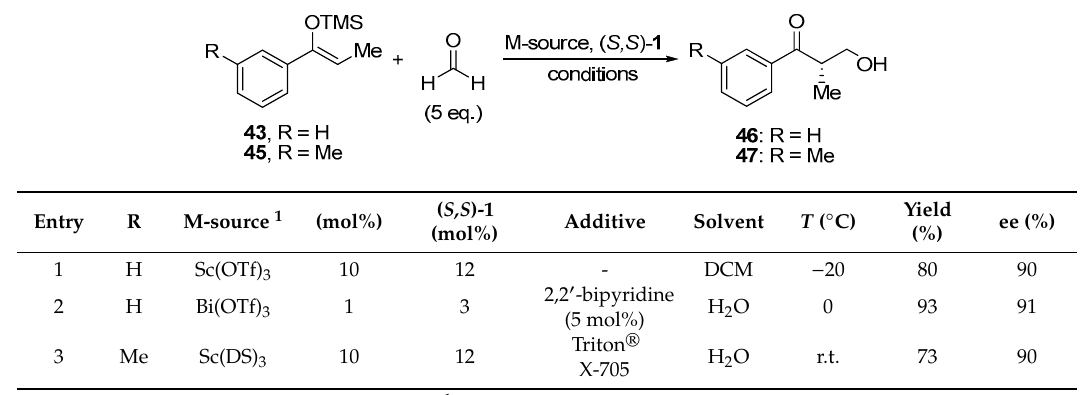
Table 10. Hydroxymethylation of silyl enol ether 43 and 45 by